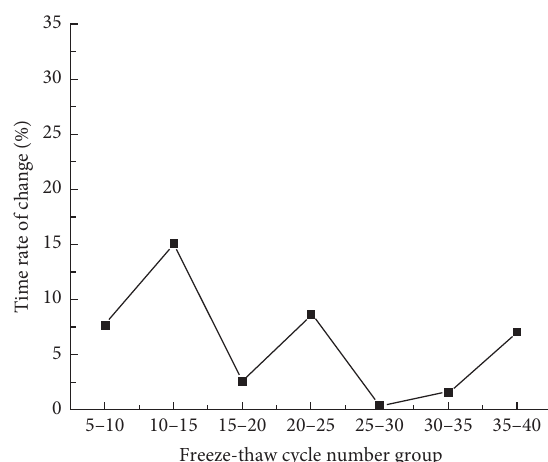
Figure 7: The change rate of the duration of the melting process after every 5 freeze-thaw cycles.